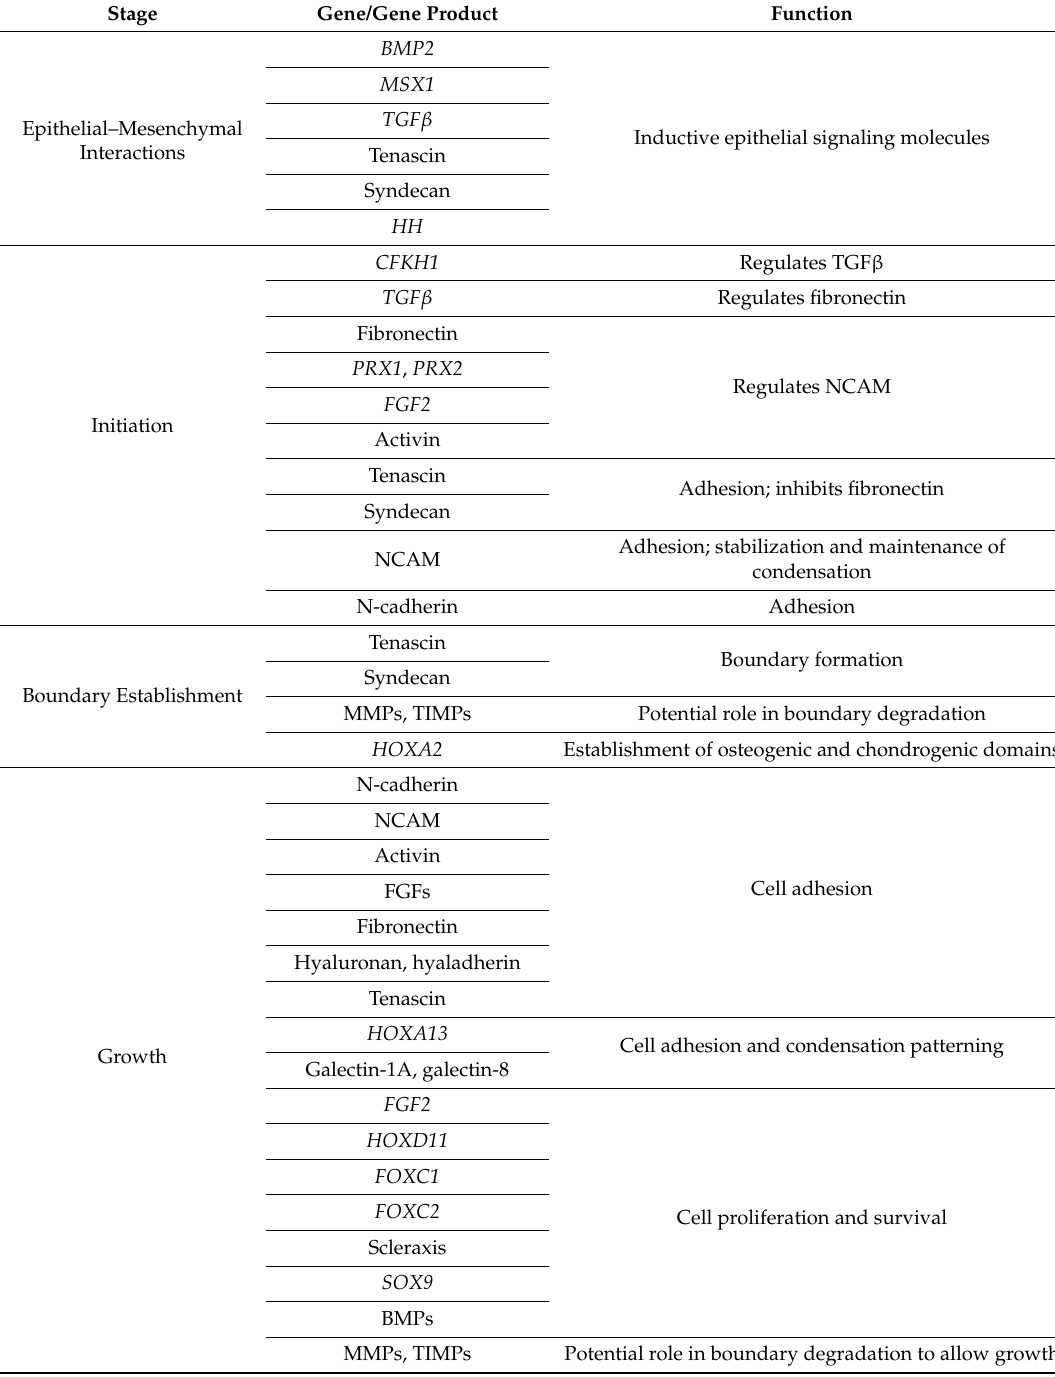
Table 1. Active signaling molecules and their function at different stages of condensation